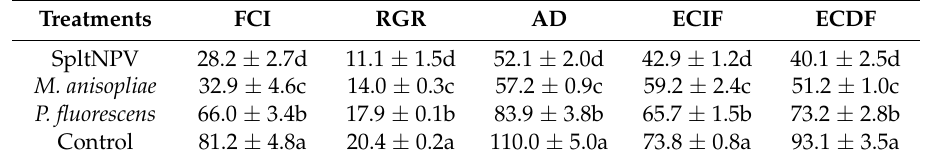
Table 1. Different nutritional indices: food consumption index (FCI), relative growth rate (RGR), approximate digestibility (AD), efficiency of conversion of ingested food (ECIF), and the efficiency of conversion of digested food (ECDF) of the third instar S. litura larvae after exposure to cotton leaf disks. Larvae were treated with either Metarhizium anisopliae , Spodoptera litura nucleopolyhedrovirus (SpltNPV), or Pseudomonas fluorescens .